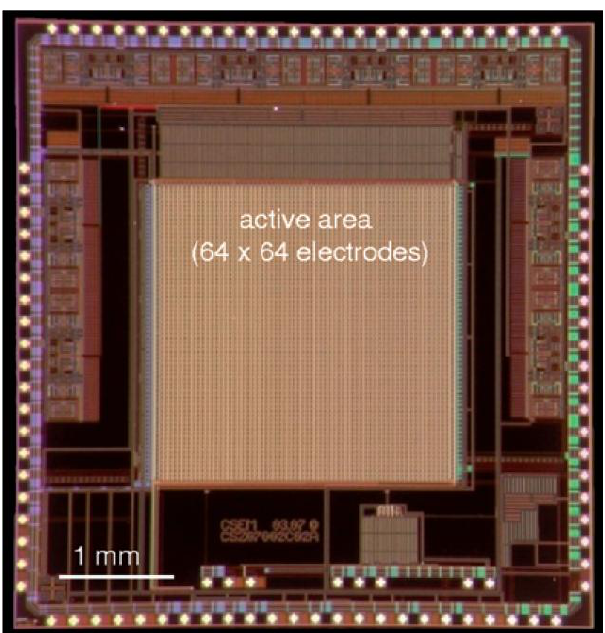
Figure 12. A CMOS-based sensor for high spatio-temporal resolution electrophysiology, produced by 3Brain. The device comprises an array of 4096 electrodes, each 21  m × 21  m. The post-processing and electrode surface material is undisclosed (from